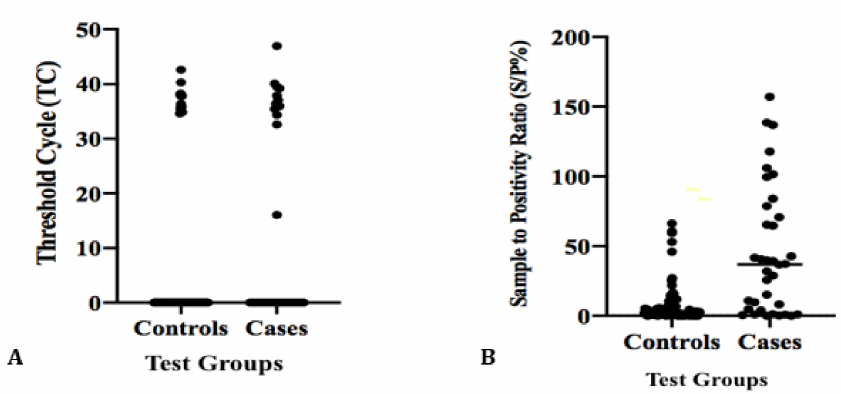
Figure 9. Scatterplots of the distribution of 128 milk samples (MIF) in two categories of healthy controls (HCs) and MAP-infected cases tested by MqPCR ( A ) and MELISA ( B ). HCs were adjusted based on the results of both SELISA and FPCR tests. The threshold cycle corresponding to MqPCR positivity was determined as being between 16 and 46 cycles ( A ), whereas the S / P% corresponding to MELISA positivity was between 31.93% and 157.11% ( B